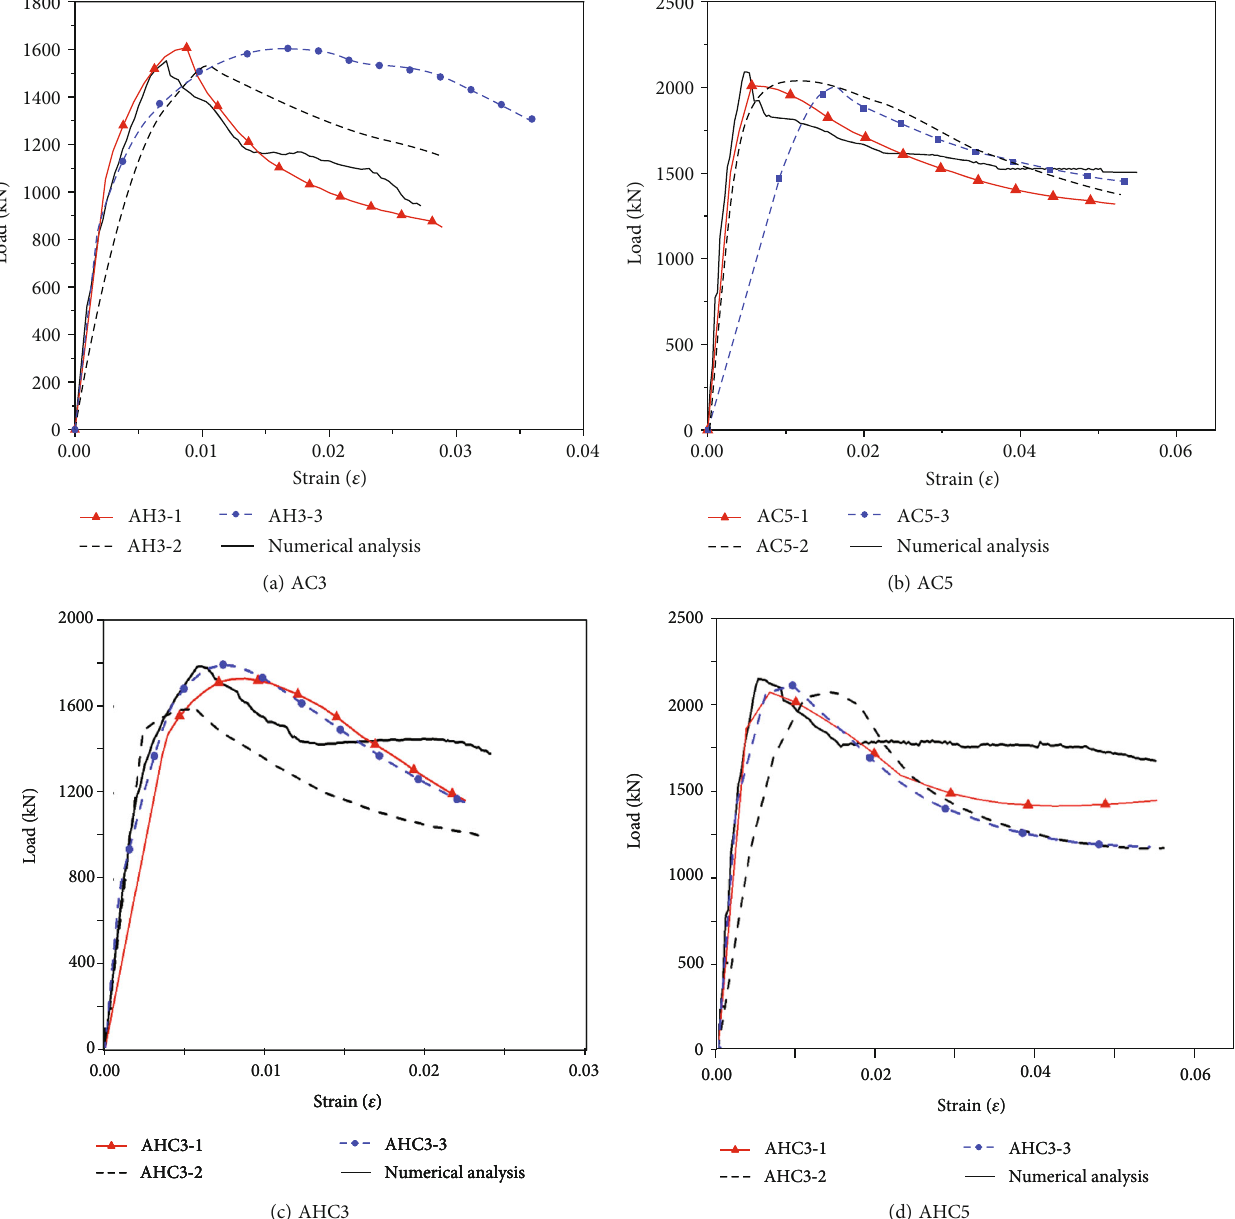
Figure 11: Comparison of experimental and fi nite element